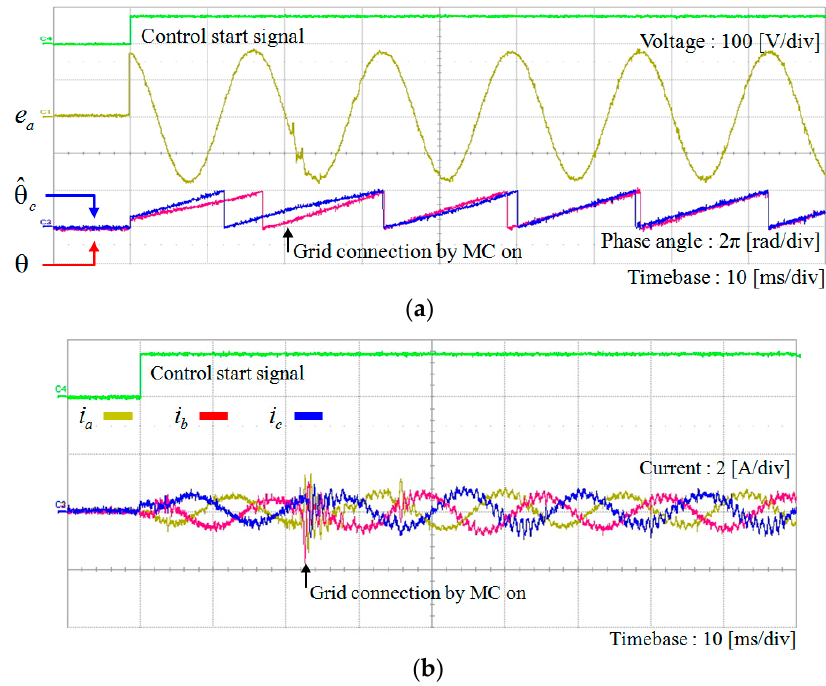
Figure 16. Phase angle estimation and transient current responses of the proposed voltage-sensorless control scheme at start-up. ( a ) Waveforms of the measured a -phase grid voltage and phase angle ˆ estimation ( θ : PLL result using the measured voltages, ˆ θ c : PLL result using the estimated voltages with compensation); and ( b ) inverter output currents at start-up.